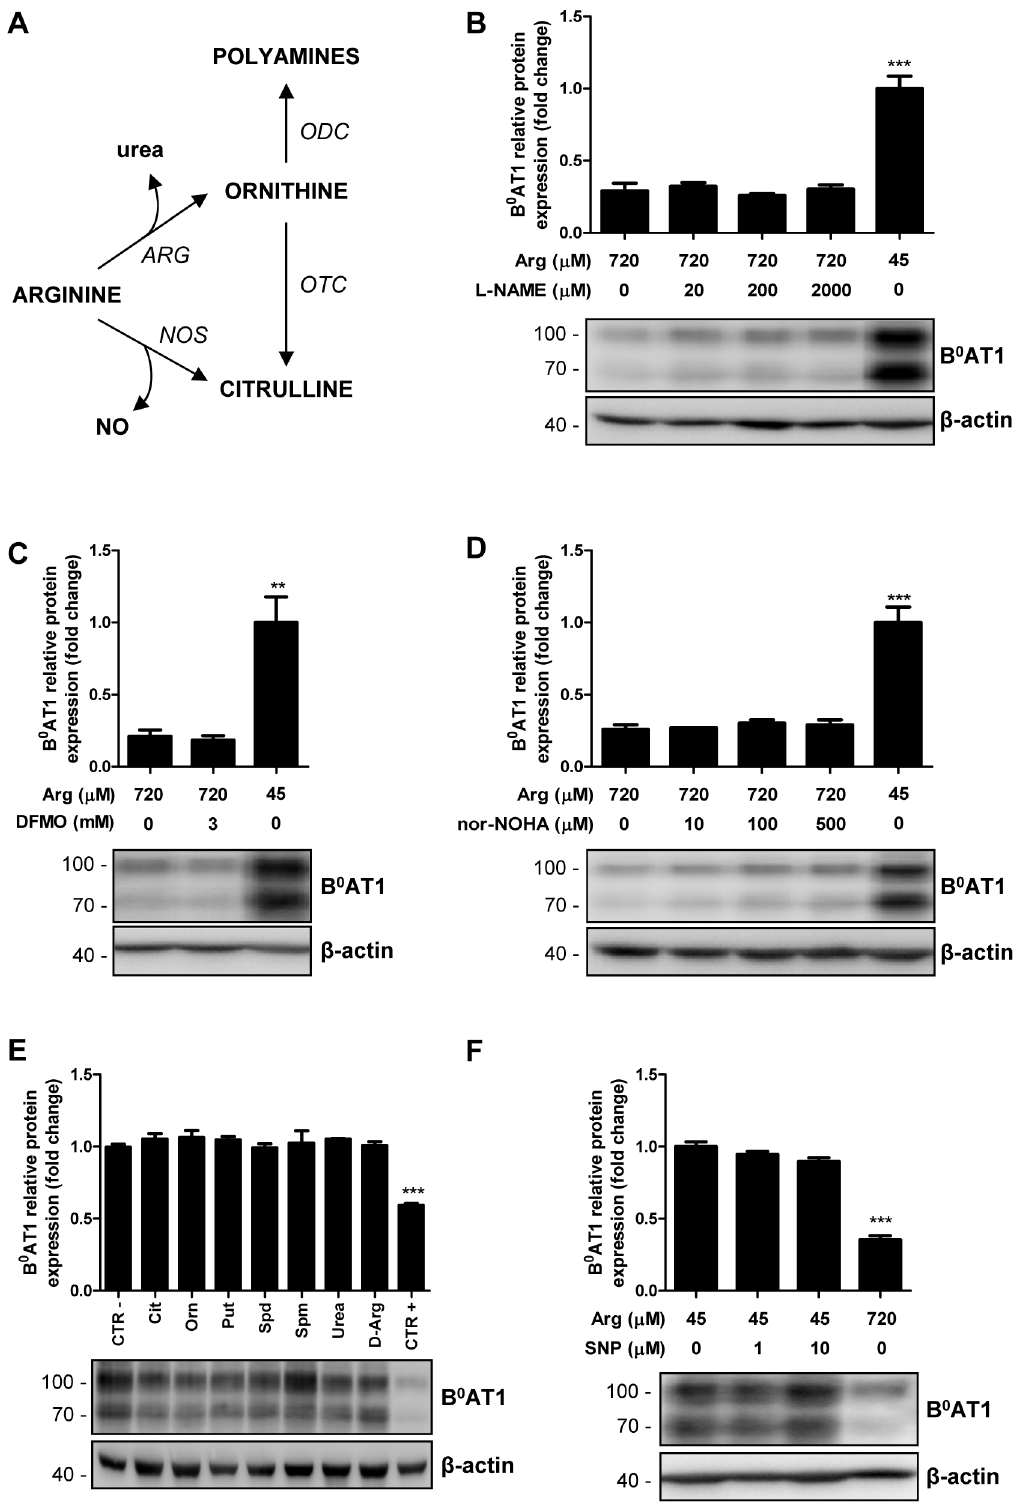
Figure 6. Effect of L-arginine metabolism on transgene expression. A: Schematic overview of some mammalian arginine metabolic pathways. ARG: arginase; NO: nitric oxide; NOS: nitric oxide synthase; ODC: ornithine decarboxylase; OTC: ornithine transcarbamylase. B–D: Mycoplasma-infected B 0 AT1-TMEM27 overexpressing MDCK cells were cultivated in arginine-free DMEM supplemented with 45 or 720 m M arginine in the presence or absence of the indicated concentrations of inhibitors of the following enzymes: (B) nitric oxide synthase (N G -nitro-L-arginine methyl ester, L-NAME); (C) ornithine decarboxylase ( a -difluoromethylornithine, DFMO) and (D) arginase (Nw-Hydroxy-nor-L-arginine, nor-NOHA). E–F: Mycoplasma-infected B 0 AT1-TMEM27 overexpressing MDCK cells were cultivated in arginine-free DMEM supplemented with 45 m M arginine in the